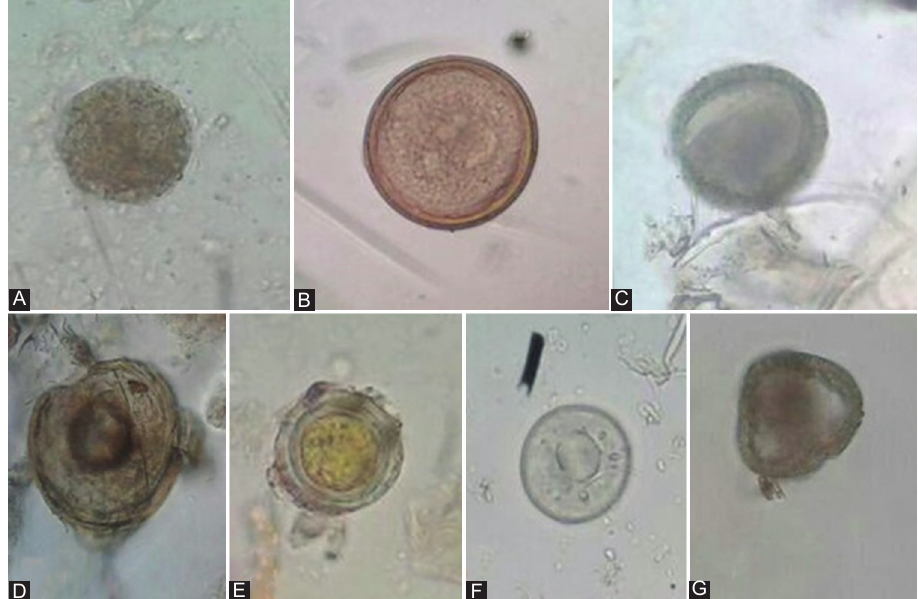
Figure-1: Images showing intestinal parasites identified in immigrant barn swallows feces in Mazandaran Province (40×). (a) Ascaridia galli , (b) Taenia spp., (c) Toxocara spp. egg, (d) Raillietina spp., (e) Choanotaenia spp., (f) Coccidia oocyst, (g) Moniezia